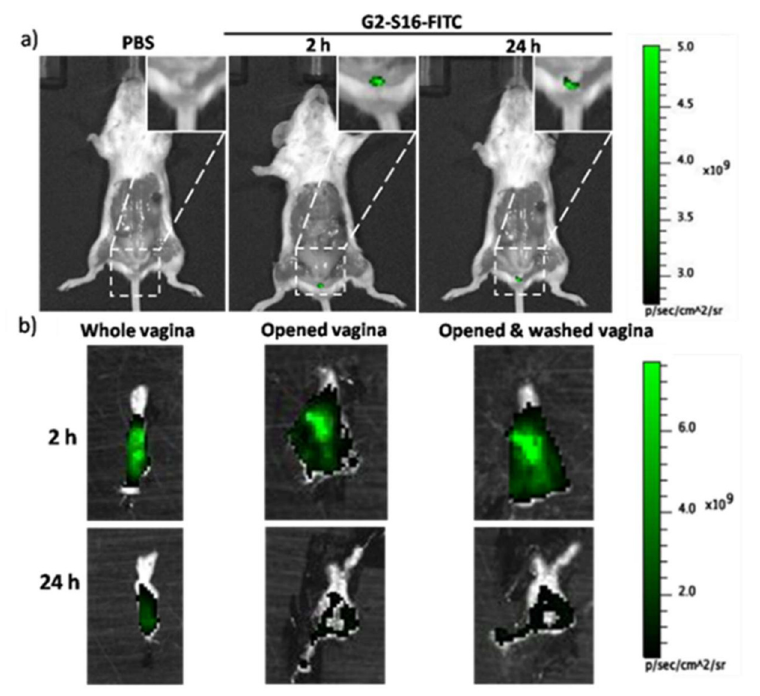
Figure 1. In vivo imaging of G2-S16-FITC dendrimer in the vagina of BALB/c mice. PBS control or G2-S16-FITC dendrimer was vaginally applied, and images of ( a ) whole mice and ( b ) extracted, opened and PBS-washed vaginas 2 h and 24 h after treatment